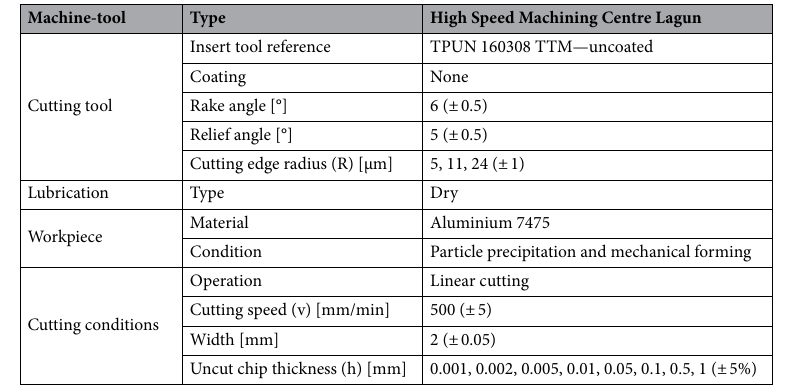
Table 4. Macroscale experimental plan.